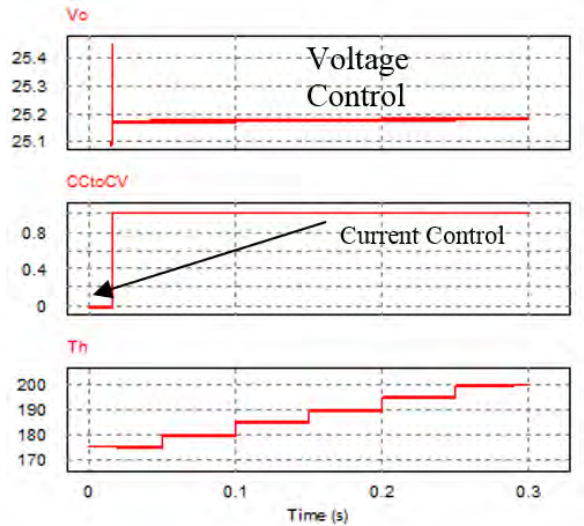
Figure 15. Output voltage at various hot side temperature values during voltage control stage